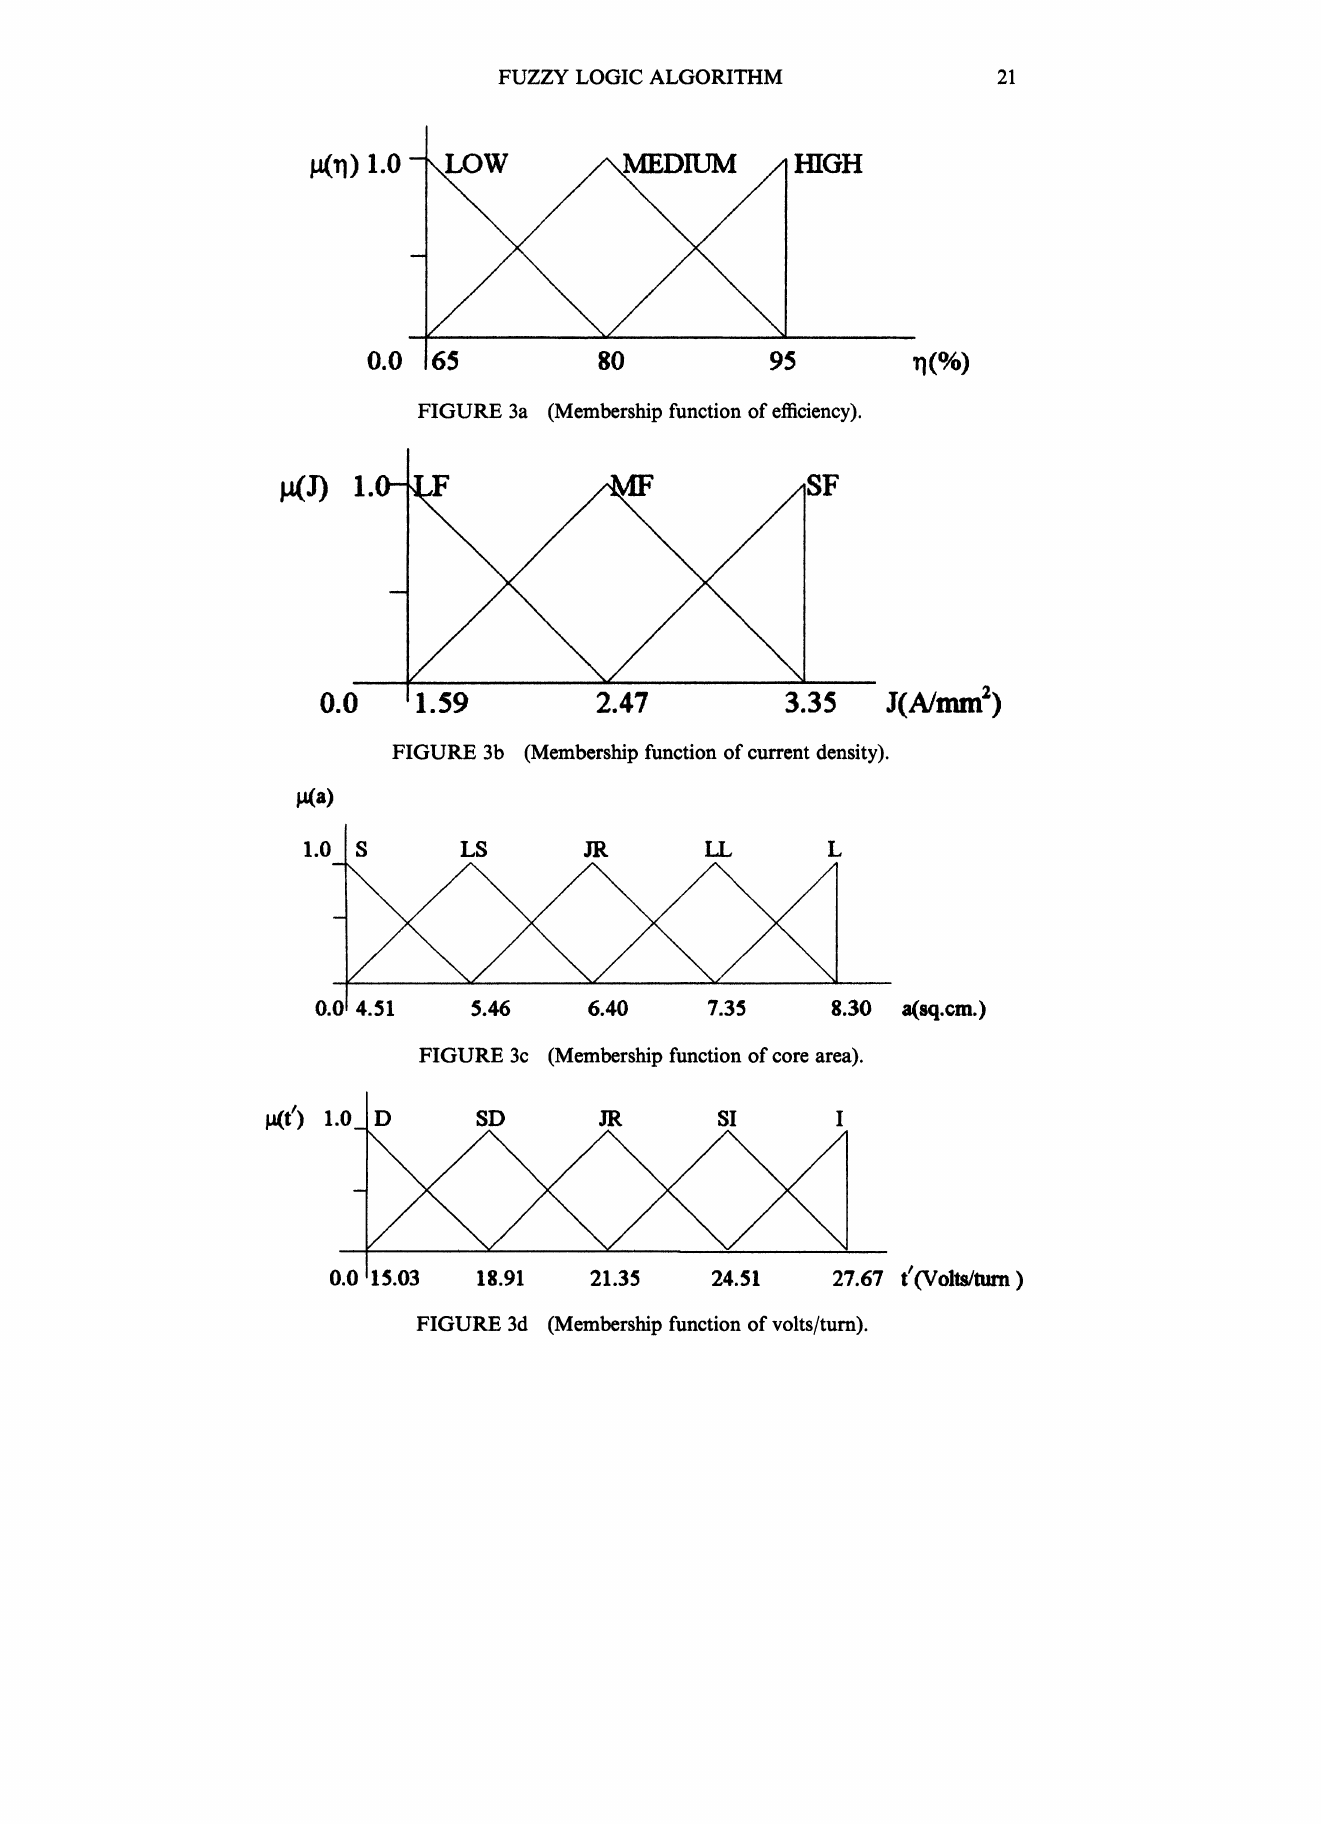
FIGURE 3a (Membership function of efficiency).